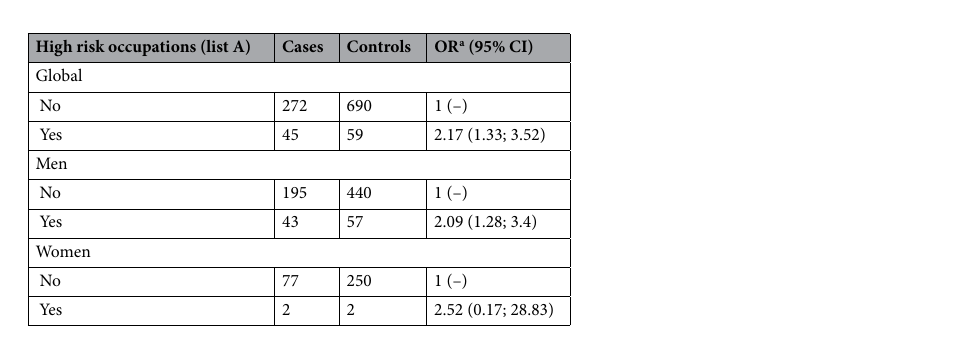
Table 2. Risk of small cell lung cancer for participants having worked in high-risk professions of lung cancer. a Adjusted by age, tobacco consumption and indoor radon exposure.